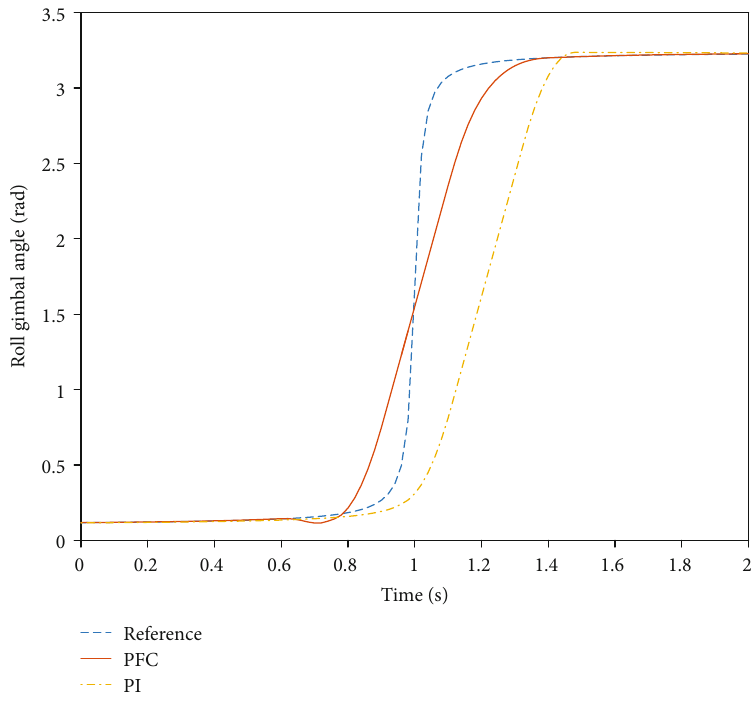
Figure 6: OG angle response of PFC and PI (1 deg, 60 deg/s).